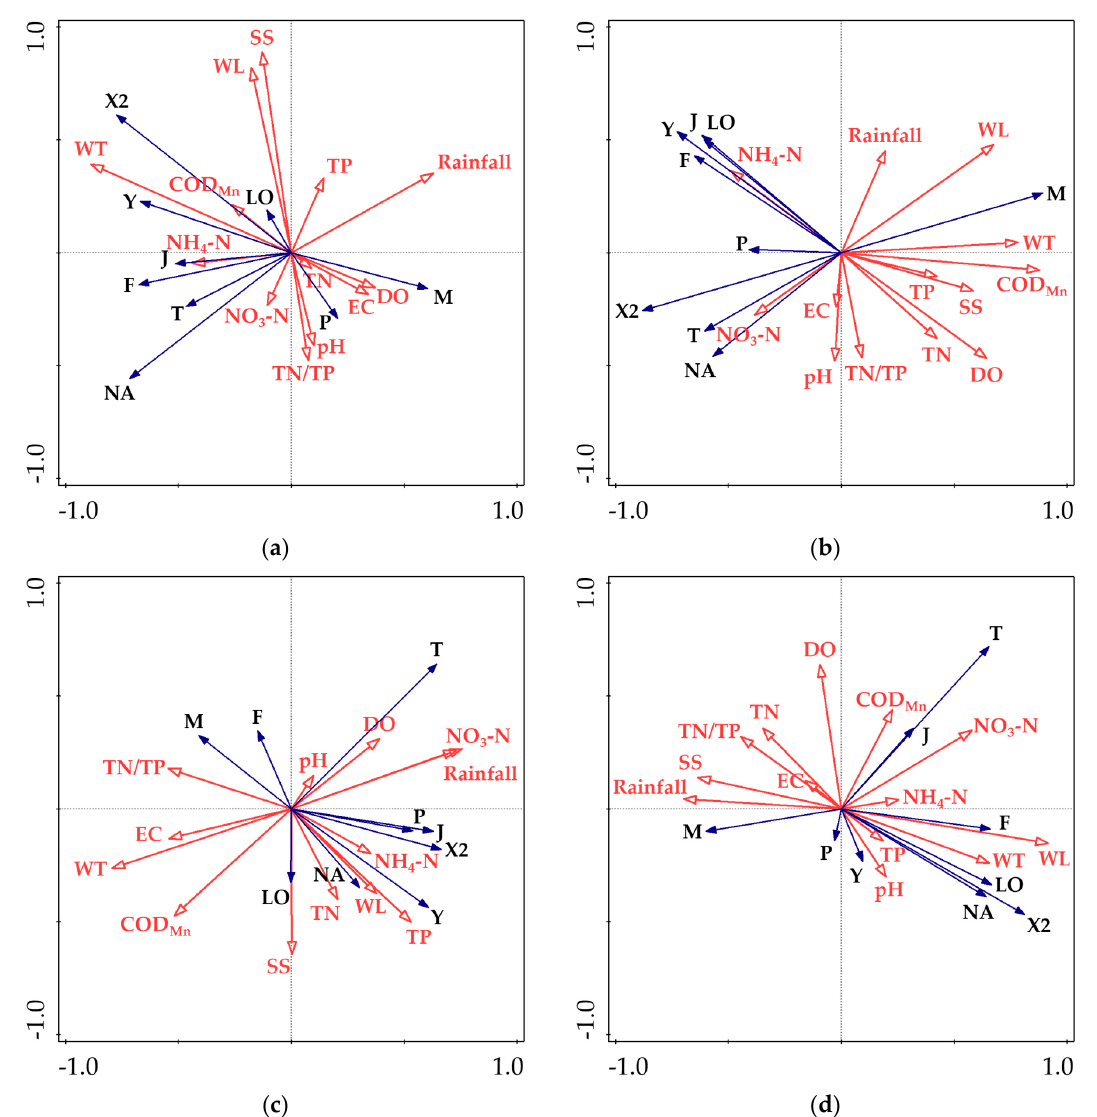
Figure 5. Redundancy analysis of the representative functional groups of phytoplankton and the environmental factors in Gaozhou Reservoir. ( a ) winter; ( b ) spring; ( c ) summer; and, ( d ) autumn.